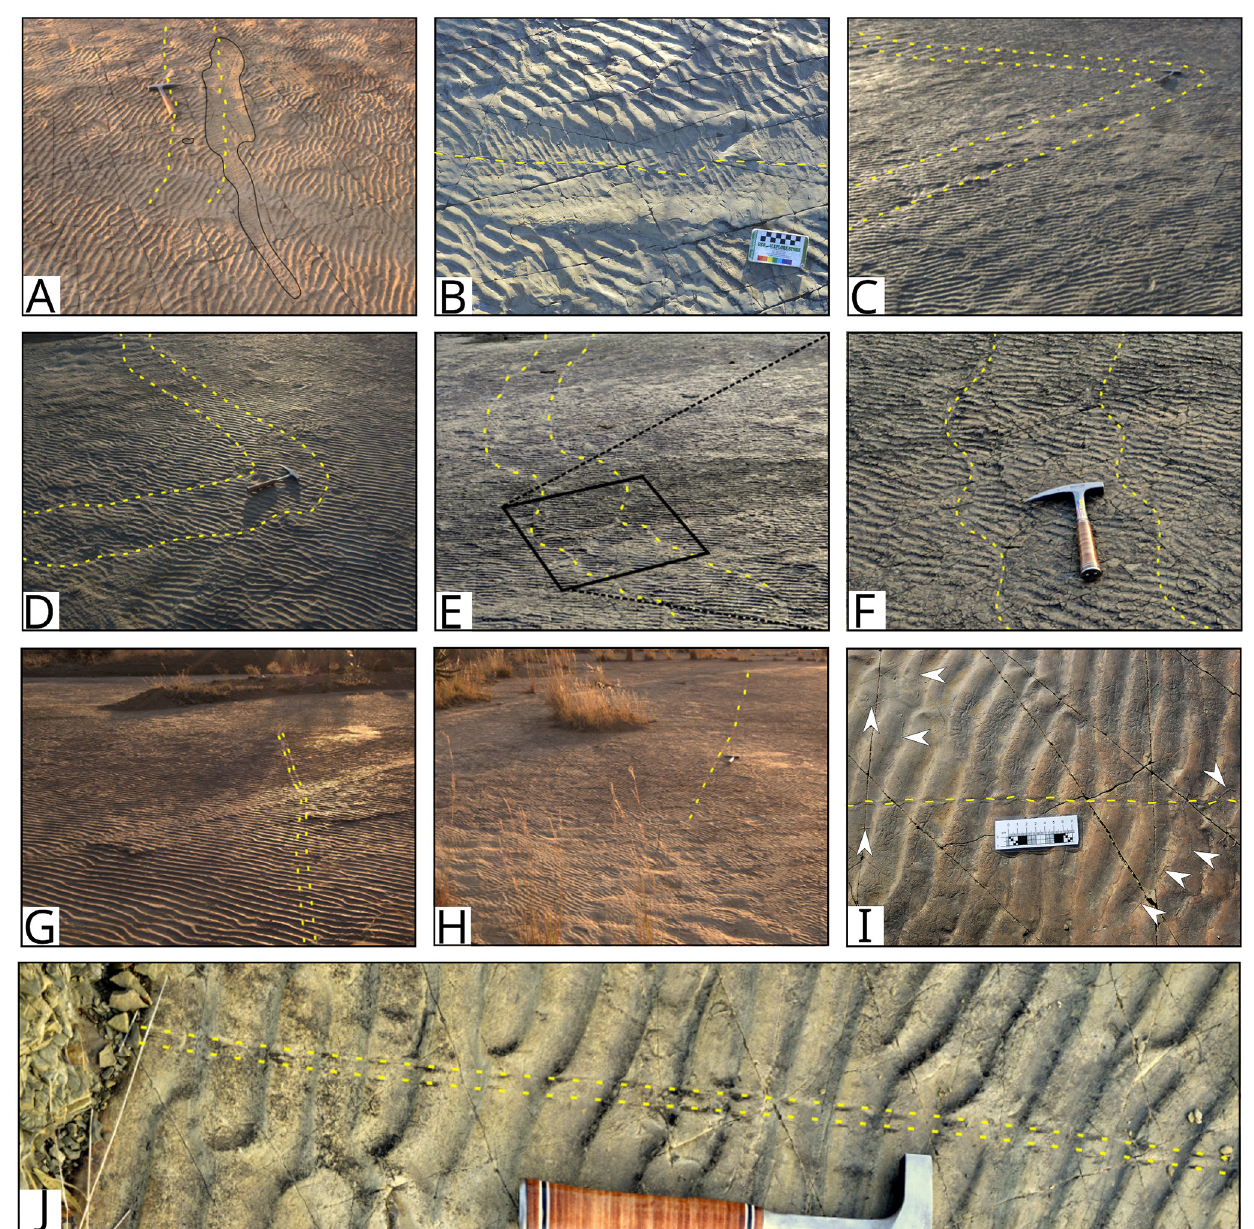
Fig 9. Linear traces preserved on the palaeosurface. A-E) A large, paired trace (LT1) can be followed southwards from the northwestern edge of the surface, overprinting (or overprinted by) Impression 1 (A and B). The trace makes a sharp turn (C and D) and heads eastwards (E). The trace is mostly straight except for a small sinuous section (F). The box outlined in E is the area shown in F. G) Paired trace (LT2) cutting through ripple crests only. The trace crosses the smoothed swim trail in the Southwestern corner of the surface. H) Long linear trace (LT3) on northern part of the surface. I) Undichna trace in north-western part of the surface (Off mapped area). Arrows show unidentified invertebrate traces. J) Linear paired trace cutting ripple crests in north-western part of the surface (Off mapped area). Hammer (~30 cm) for scale (A, C, D, F, H and J). Scale card in B = 8 cm and numbers on scale card in I =